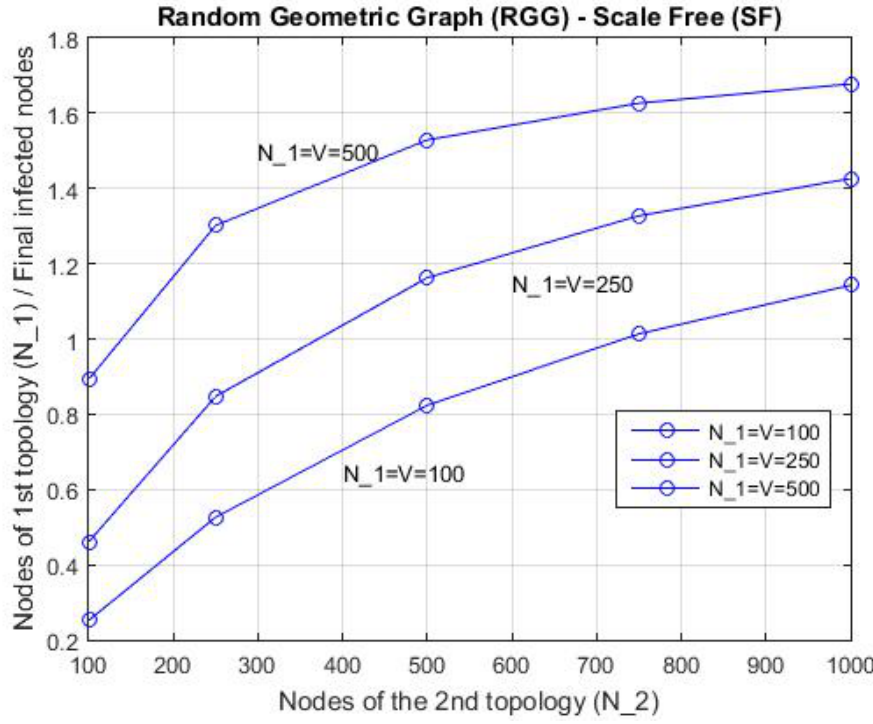
Figure 2. Random Geometric Graph with scale-free, while N_1 = 100, N_1 = 250 and N_1 =